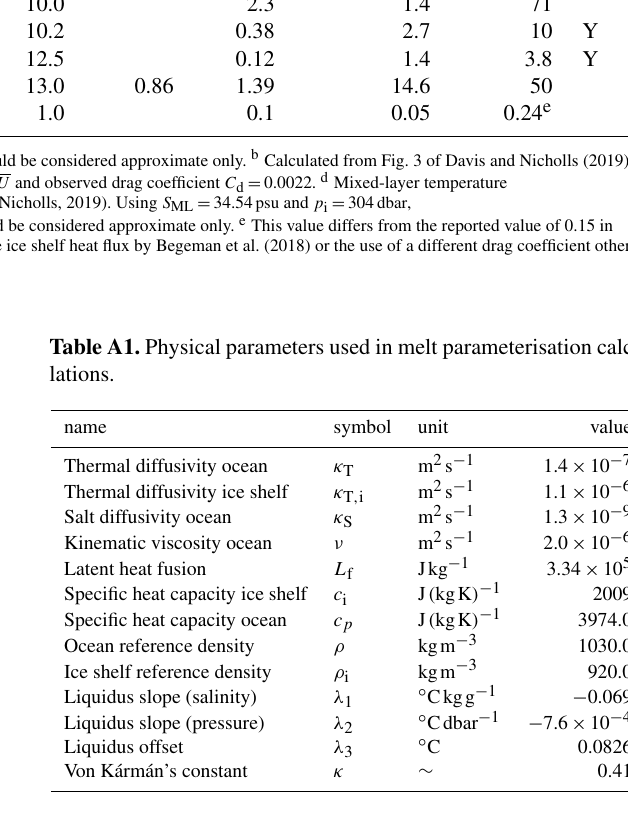
Table 4. Comparison between observed and predicted melt rates for a series of Antarctic ice shelves for which both melt rates and in situ oceanographic data are available. Observed variables presented are the time-mean current speed ( U ), time-mean friction velocity ( u ∗ ), thermal driving ( T ∗ ), and melt rate ( m OBS ). Melt rate predictions made from J10 are also presented for each site. Where they are in bold, we have used the estimate from the original study. In the final column we note sites with a strong tidal component to the flow. Location